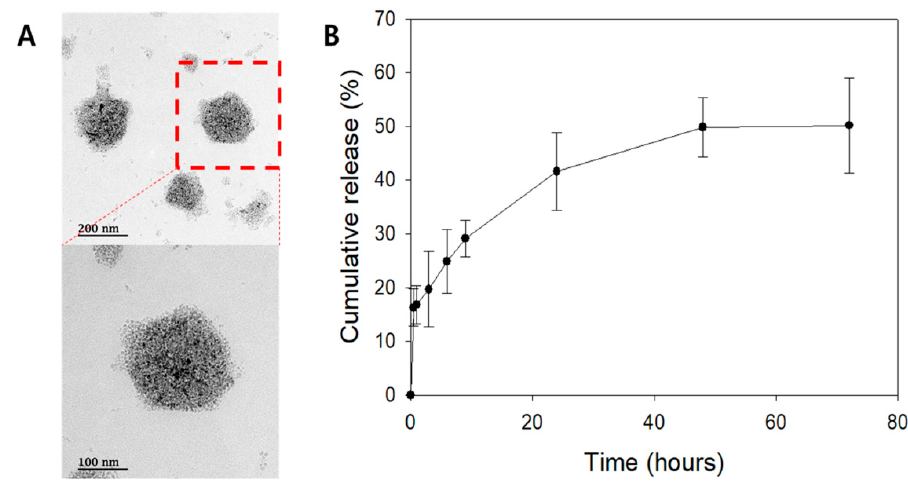
Figure 3. Liposome characteristics. ( A ) Transmission electron microscopy (TEM) image of nonloaded liposomes. ( B ) Cumulative TSA release profile of TSA-loaded liposomes.